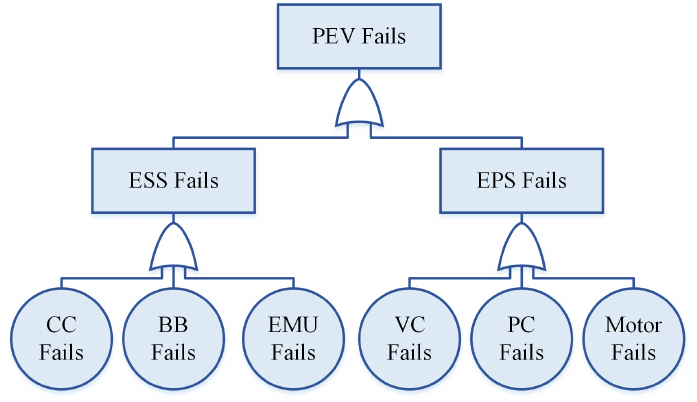
Figure 3. Fault-tree diagram of the PEV